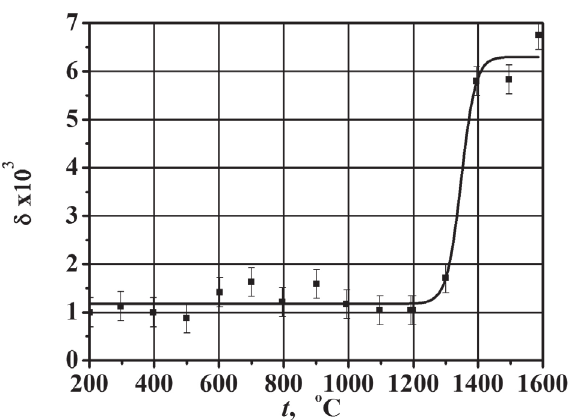
Figure 8. Dependence of internal friction of the irradiated rheni- um samples on the isochronous annealing